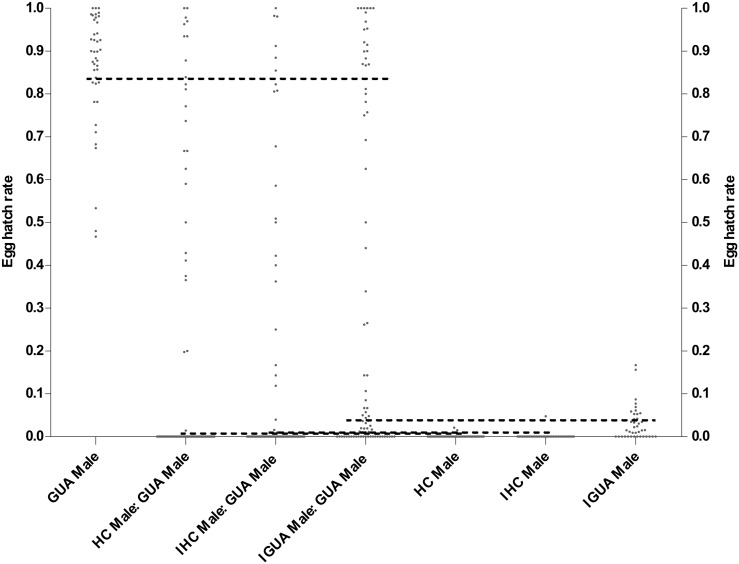
Distribution of egg hatch rates for individual GUA females recollected from experimental cages containing a 5:1 ratio of sterile (HC, IHC and IGUA males) to fertile GUA males or from control cages containing only sterile or fertile males in the large cages.The black solid line represents the lower SE of the mean egg hatch rate of either the fertile cages or higher SE of the mean in sterile cages. These limits were used to assign egg batches from competitiveness treatments to either sterile or fertile mating events. Egg batches of an individual female with a hatch rate between the lower SE of the fertile cages and the higher SE of the sterile cages were defined as being intermediate—from an indeterminate mating event.